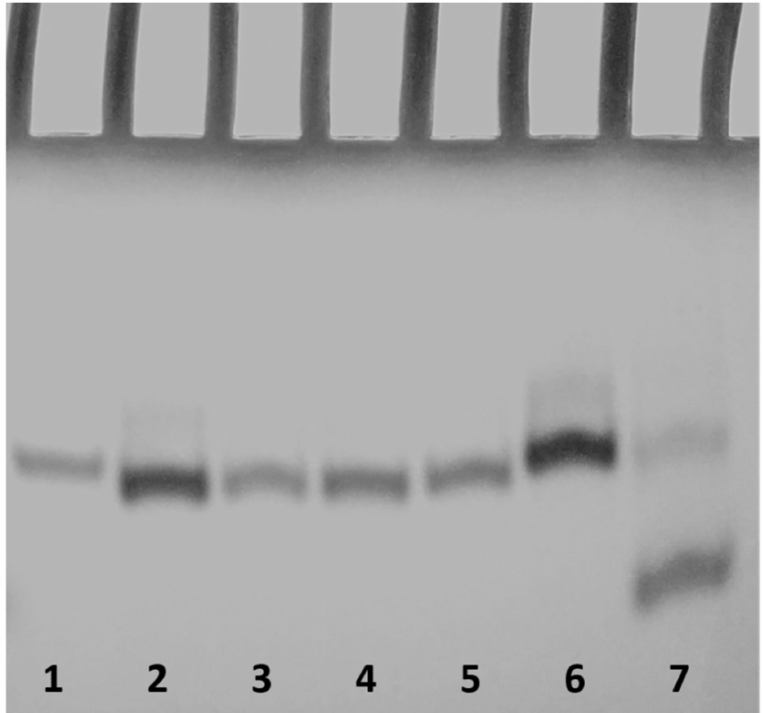
Figure 4. PAGE analysis of the T30175 analogues investigated. Lane 1: INT-B ; lane 2: INT-BS2 ; lane 3: INT-BS5 ; lane 4: INT-BS9 ; lane 5: INT-BS13 ; lane 6: INT-BS17 ; lane 7: TT-INT-B